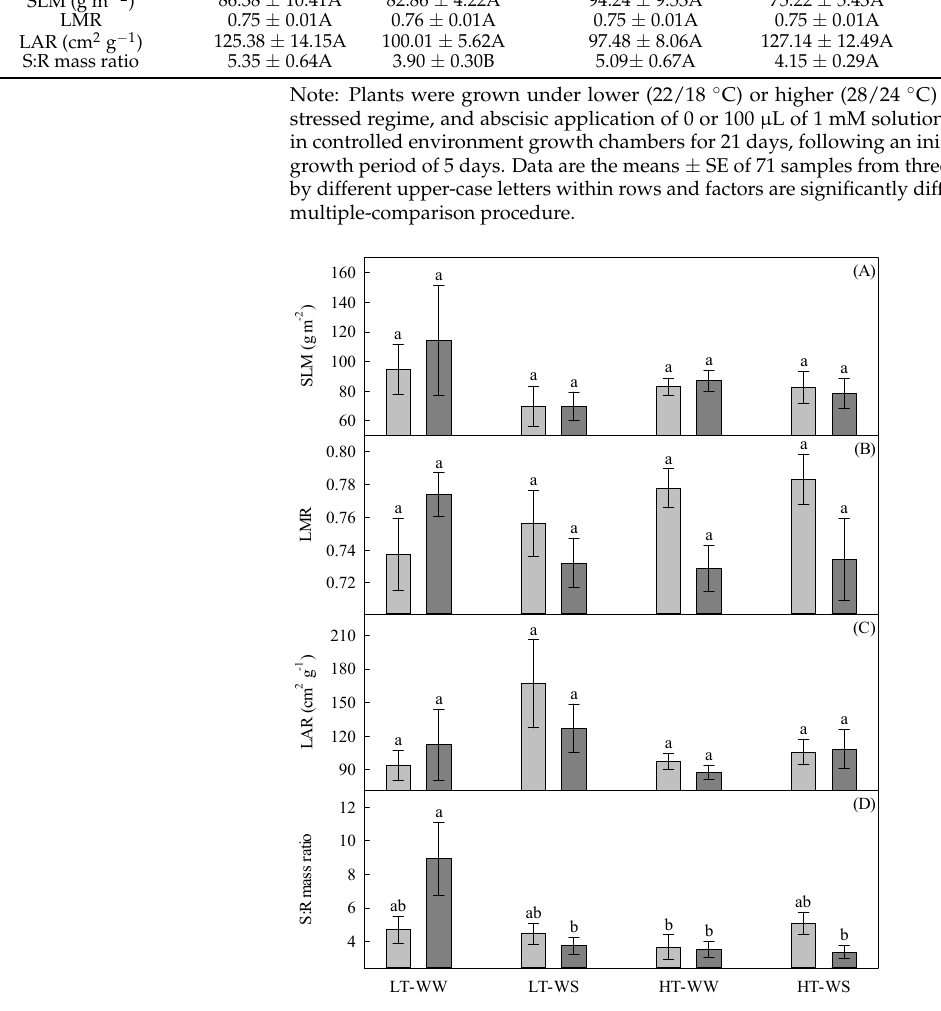
Table 8. Effects of temperature, watering regime, and abscisic acid on growth indices of tomato plants. Parameter